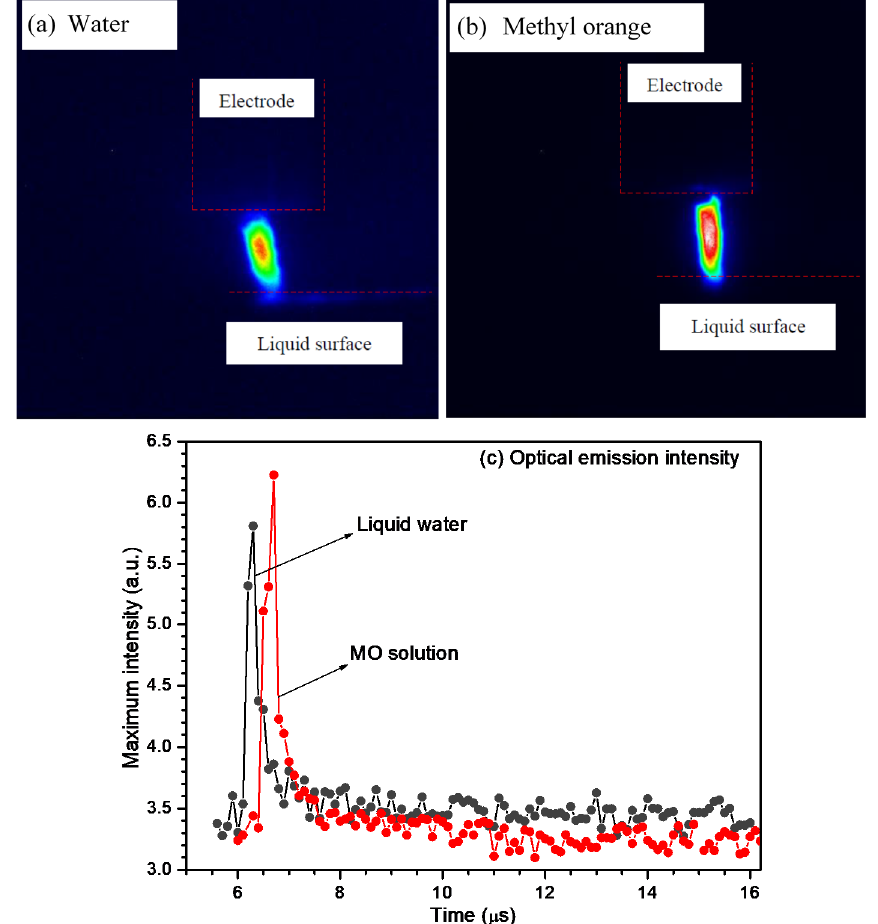
Figure 3. Typical arc plasma images ( a , b ) and their optical emission intensities ( c ) with SUS as the electrode [38].